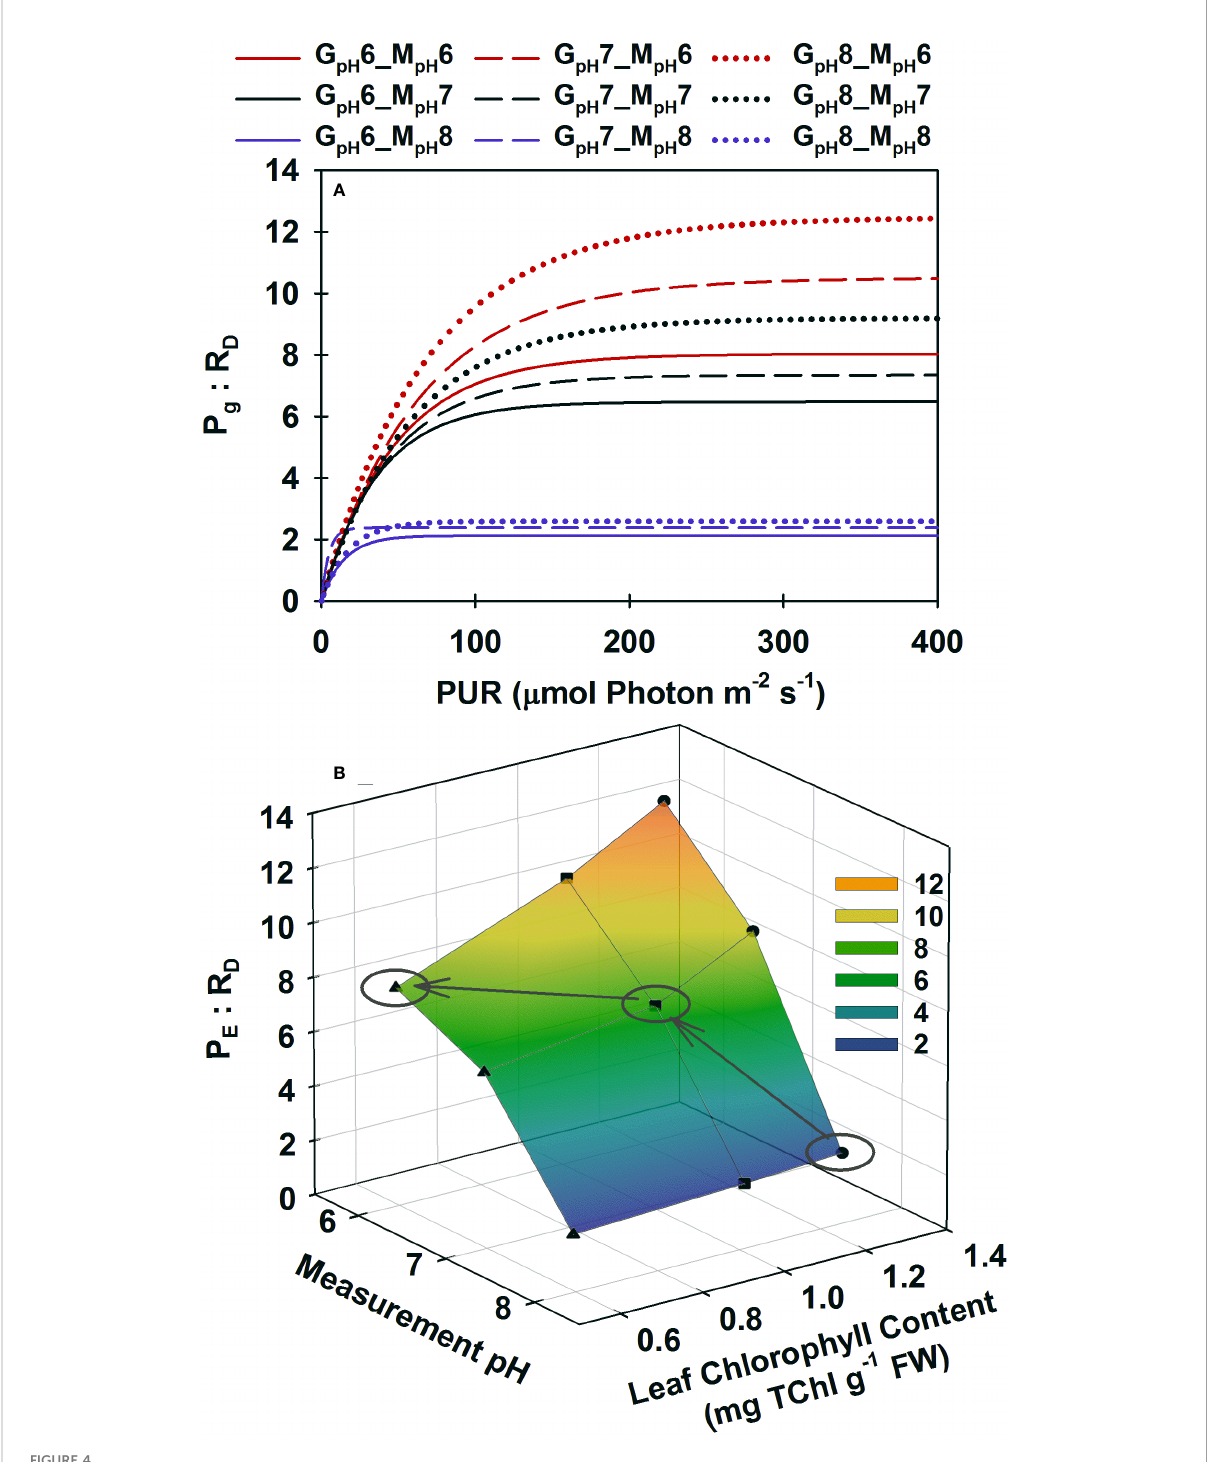
FIGURE 4 Modeled ratio of gross photosynthesis to dark respiration as a function of absorbed irradiance (A) and as a function of Chlorophyll content at saturating irradiances (B) . Colors represent different pH/CO 2 levels at which the measurements (M pH ) were performed; line styles and symbols ( ▲ , at pH6 ◼ at pH7, ● at ambient pH) represent the different pH/CO 2 levels at which the plants were grown (G pH ). (B) Ellipses highlight when plants from different treatments were incubated at their corresponding growth pH/CO 2 . Gray arrows show the trajectory of P E : R D as a result of phenotypic acclimation to the increasing CO 2